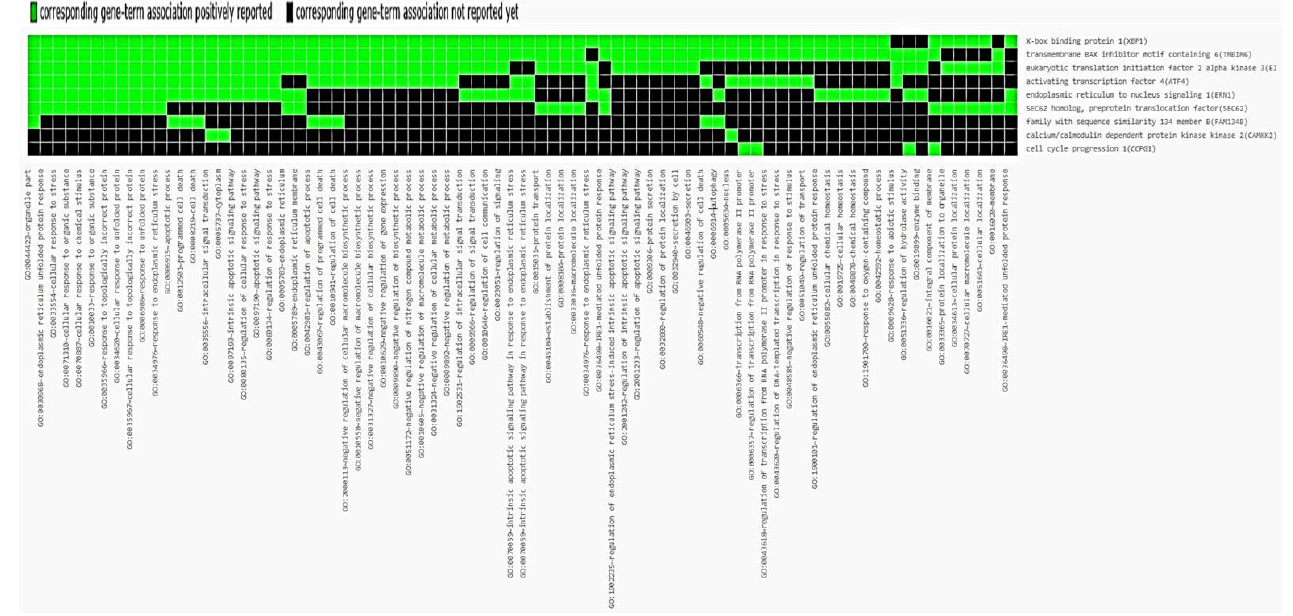
Figure 5. Analysis of clinical data using DAVID bioinformatics tools. Figure depicts the corresponding gene-term association of ER stress proteins, ERphagy proteins, and Ca 2+ signaling proteins.